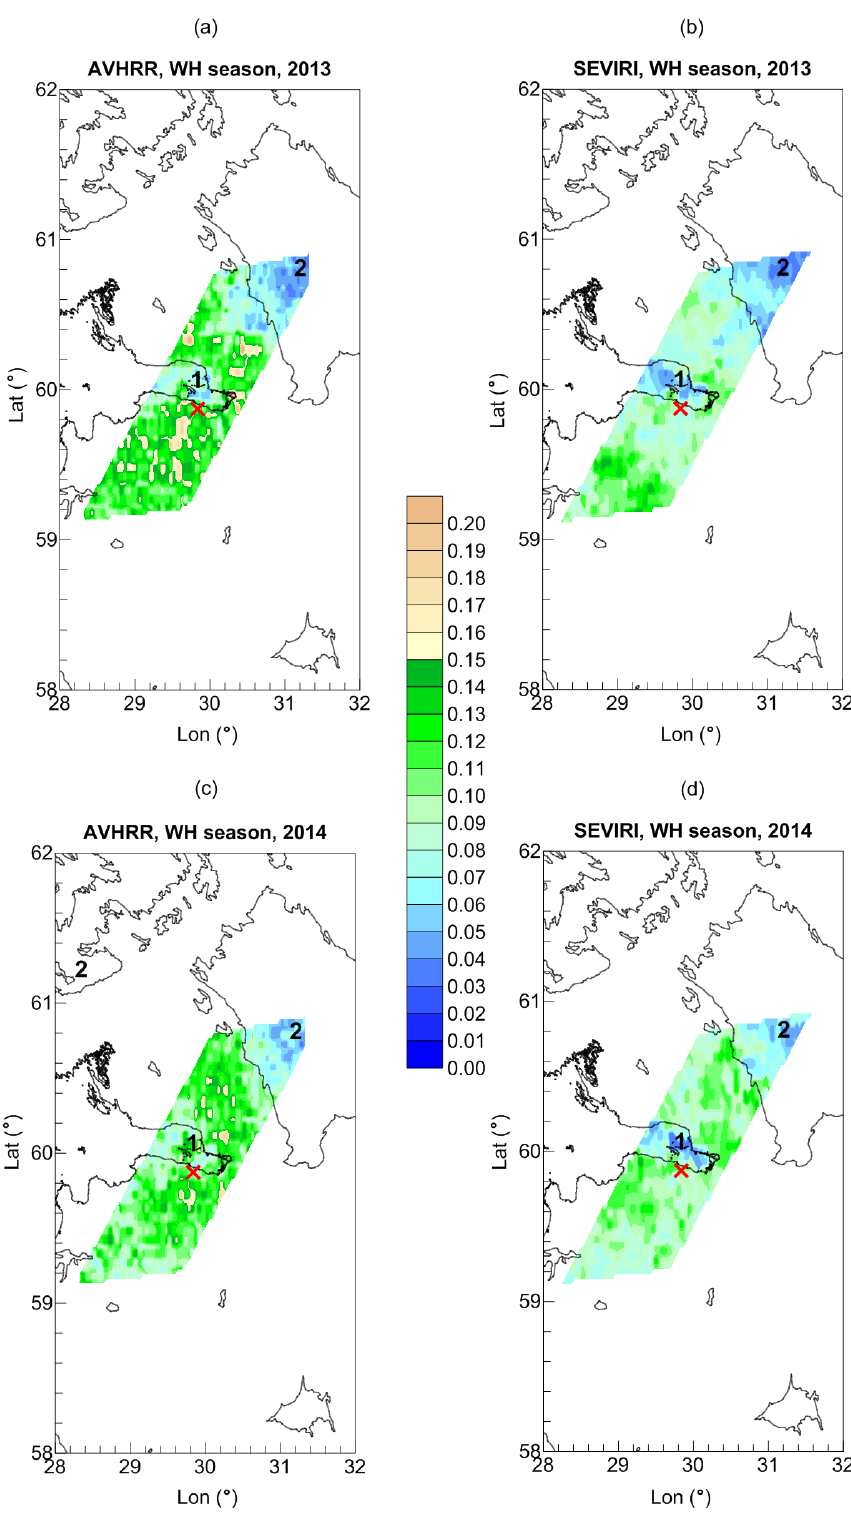
Figure 11. The maps of the mean LWP values (AVHRR and SEVIRI measurements, colour scale, kgm − 2 ) calculated for the large terrain for the WH season of 2013 (a, b) and 2014 (c, d) . The location of HATPRO radiometer is marked by the red cross. The black numbers identify the following objects: 1 – Neva Bay, 2 – Ladoga Lake. Vector shoreline data: GSHHG